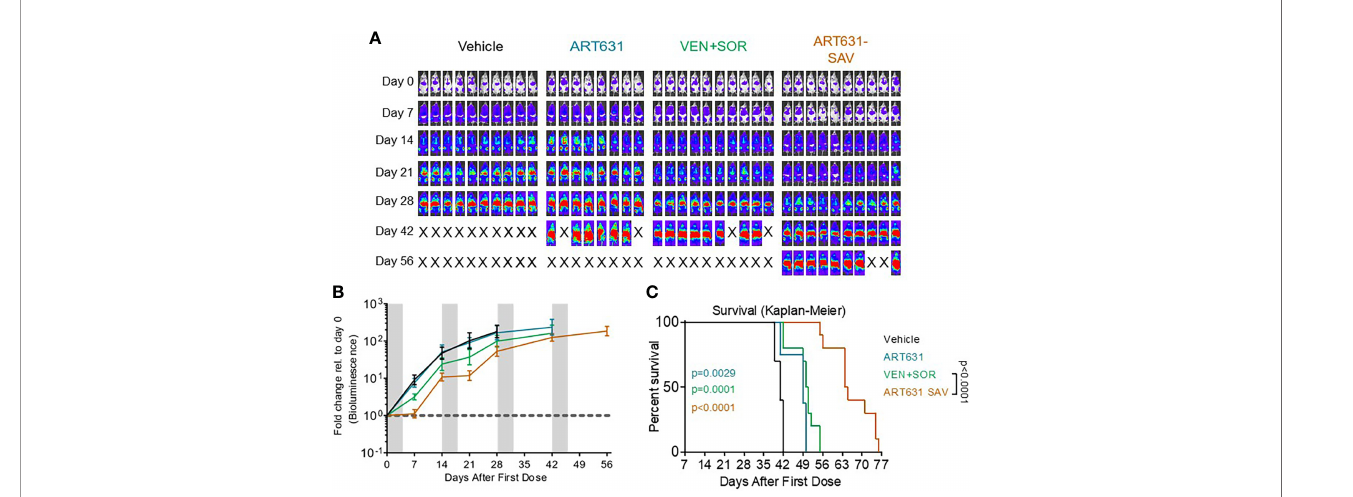
FIGURE 9 | VEN plus SOR plus ART631 inhibited growth of an AML PDX. NRG mice bearing luc/YFP-labeled AML45 PDX were prepared as in Figure 7 . (A) After Xenogen quanti fi cation of baseline total body luminescence on day 0, mice were placed into balanced experimental groups prior to drug administration via gavage, then treated per our previously established MTD PO x 5 day schedule (5 days on, 9 days off). Mice were treated with 15 mg/kg/d ART631 as monotherapy, with 150 mg/kg/d VEN and 30 mg/kg/d SOR, or with ART631 plus VEN plus SOR (i.e. SAV) at the previously indicated doses for 4 identical 5-day treatment cycles over 8 weeks. This PDX experiment was also performed simultaneously with the previously reported AML45 PDX experiment with ART838 and ART838-containing SAV (20). Treatment response outcomes were measured by (B) leukemia response quantitation (fold-change in leukemia burden on day 7 (and later) versus day 0 for each mouse via Xenogen imaging (grey-shaded bands on graphs indicate days when mice were treated). Error bars represent the SD offold-change in leukemia burden of mice in each treatment group. (C) shows corresponding Kaplan-Meier survival curves. Comparisons between treatment groups were calculated by log-rank (Mantel-Cox)